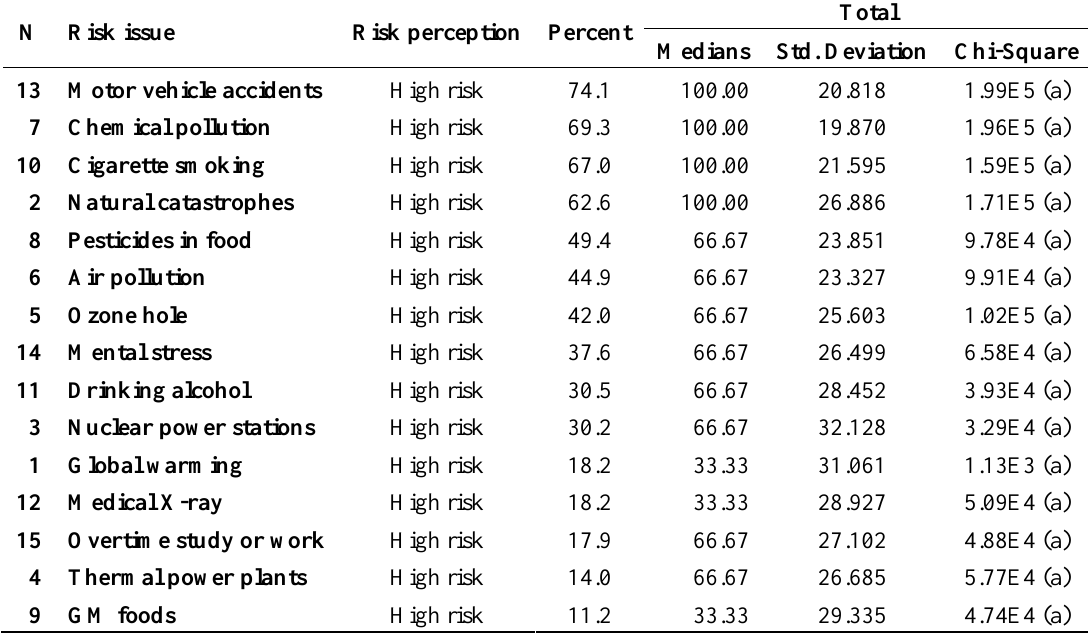
Table 2. Health risk perceptions among Chinese college